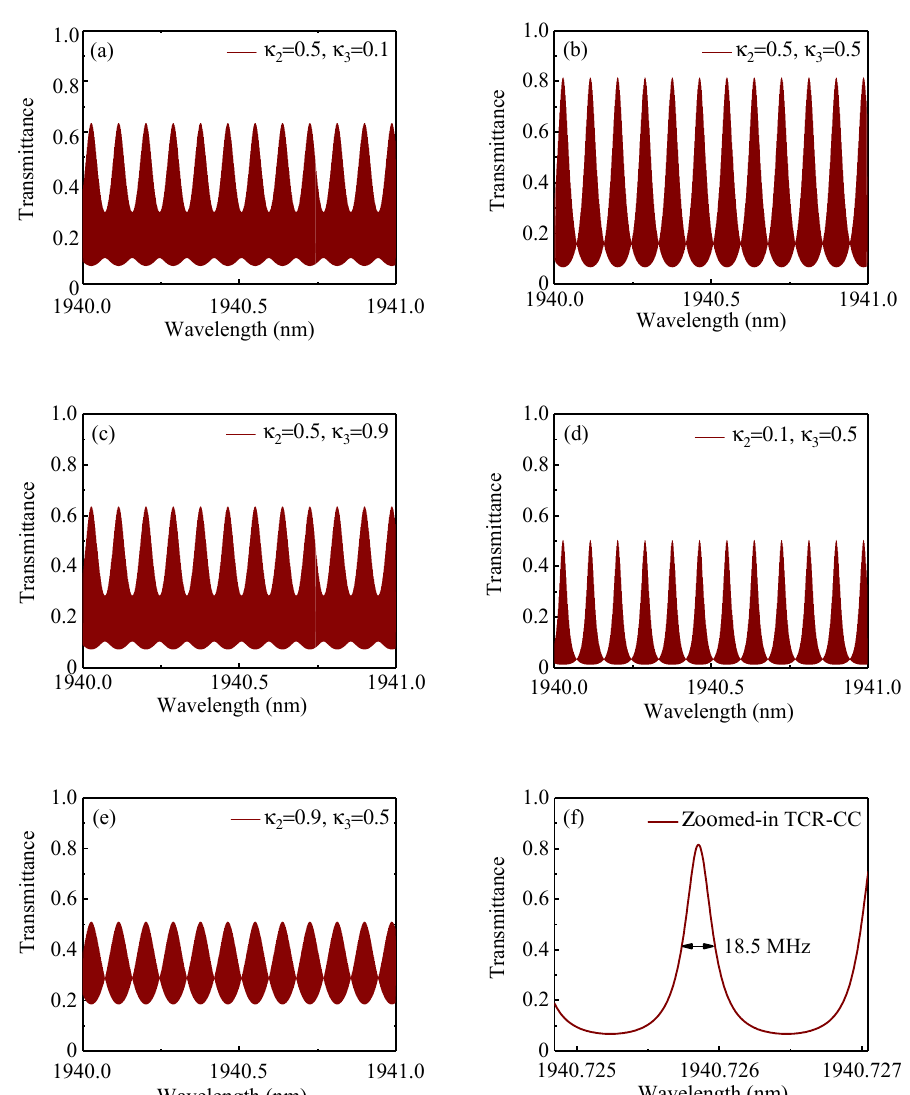
Figure 3. Simulated spectra of the proposed TDCR-CC filter ( a – e ) showing the influence of the ratio on the transmission performance. ( f ) The zoomed-in transmission spectrum of TCR-CC at main resonance peak.